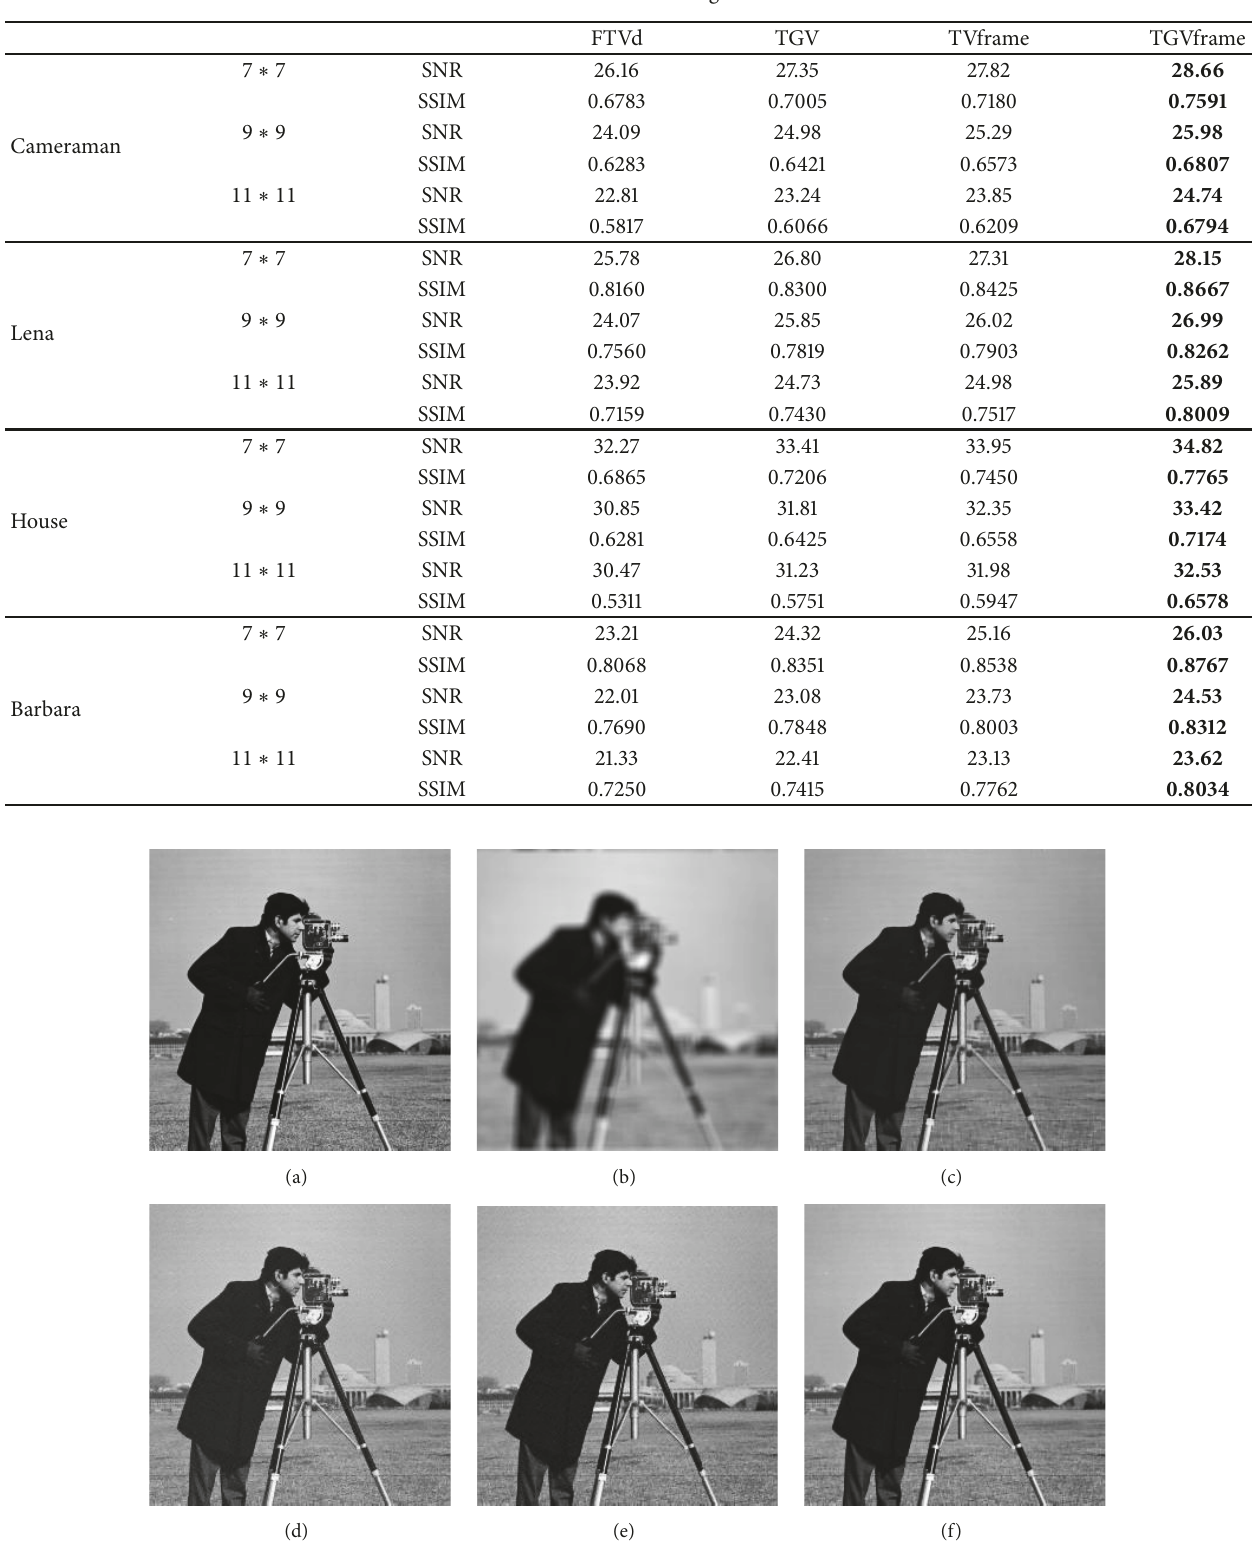
Figure 2: Restoration results of the Cameraman image with Gaussian blur kernel. (a) Original image; (b) blurred and noisy image; (c) image deblurred by FTVd; (d) image deblurred by TGV; (e) image deblurred by TVframe; (f) image deblurred by